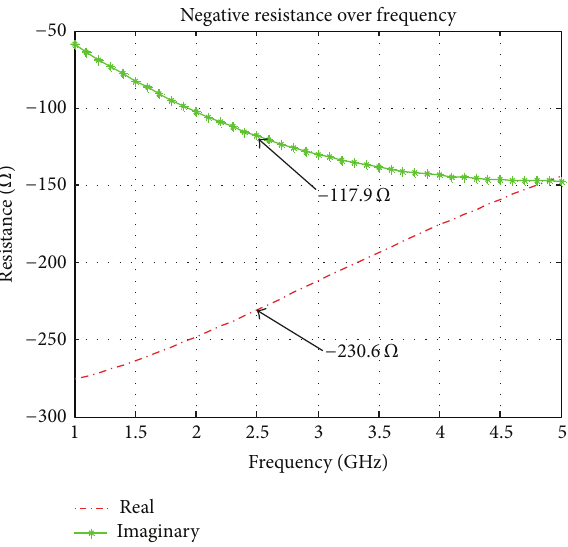
Figure 6: Simulated negative resistance